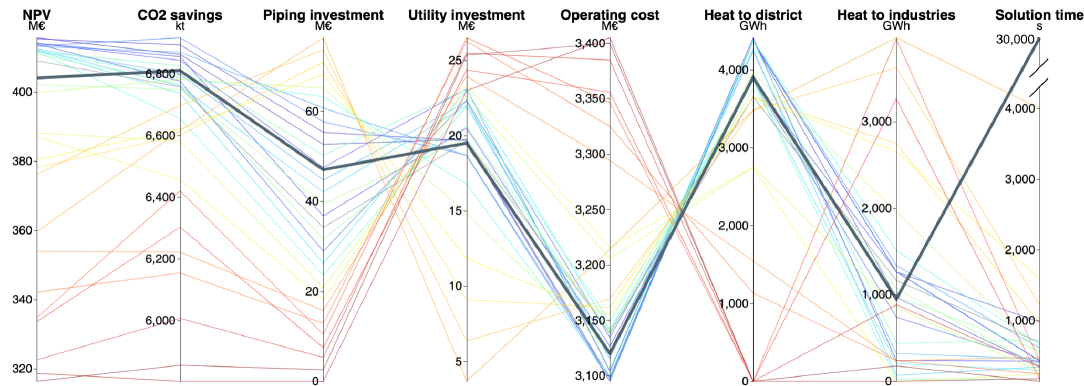
Figure 10. Multiple solutions generated by parametric optimisation; the higher the NPV, the colder the line